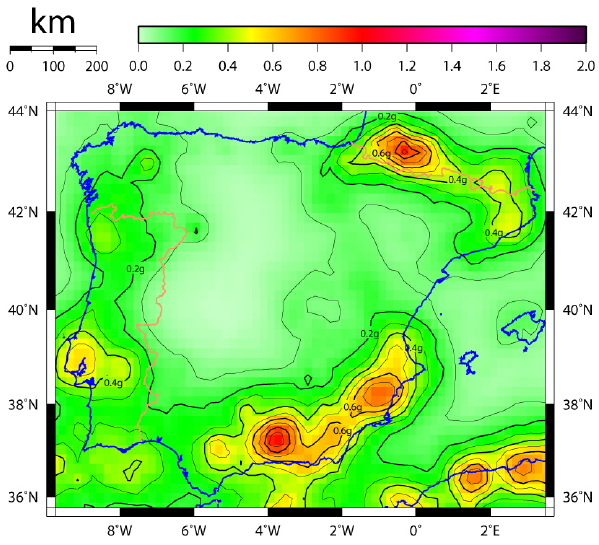
Figure 13. Maximum amplification of the accelerations for 475yr return period, measured by the ratio of the plateau to the